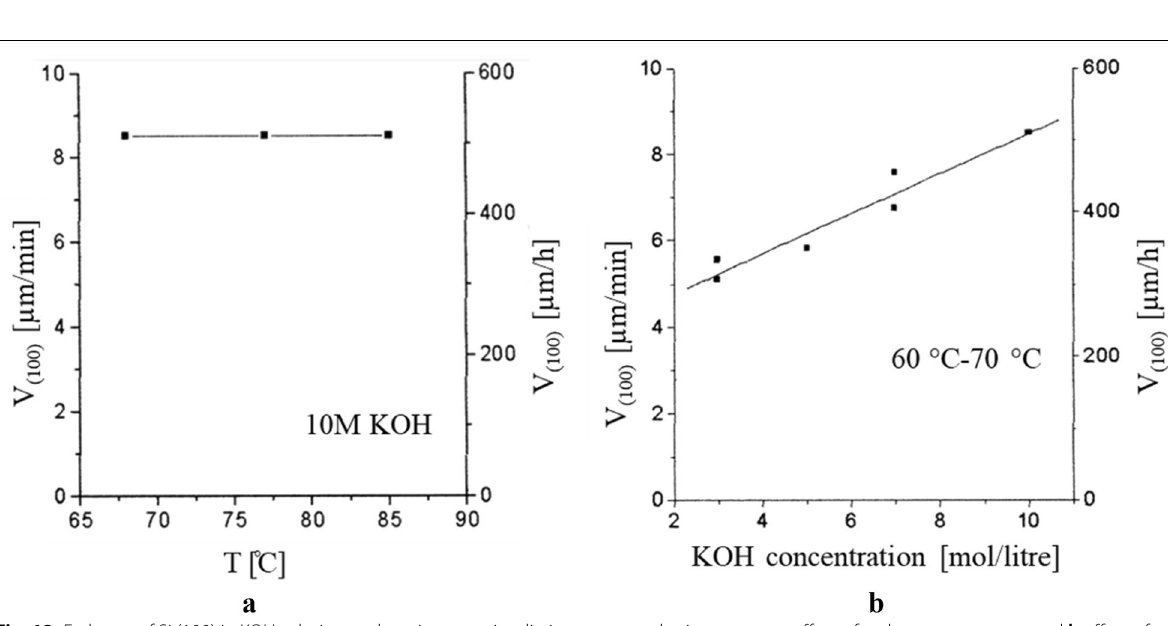
Fig. 12 Etch rate of Si (100) in KOH solution under microwave irradiation at atmospheric pressure: a effect of etchant temperature and b effect of KOH concentration [67], © 2000,